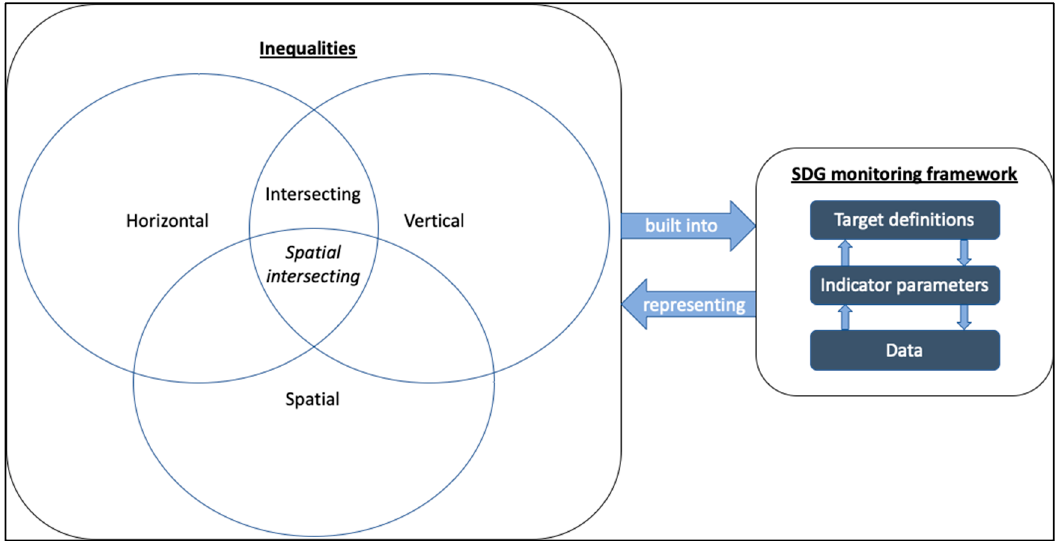
Figure 1. Conceptualising the interaction between inequalities and the SDG monitoring framework (own figure).